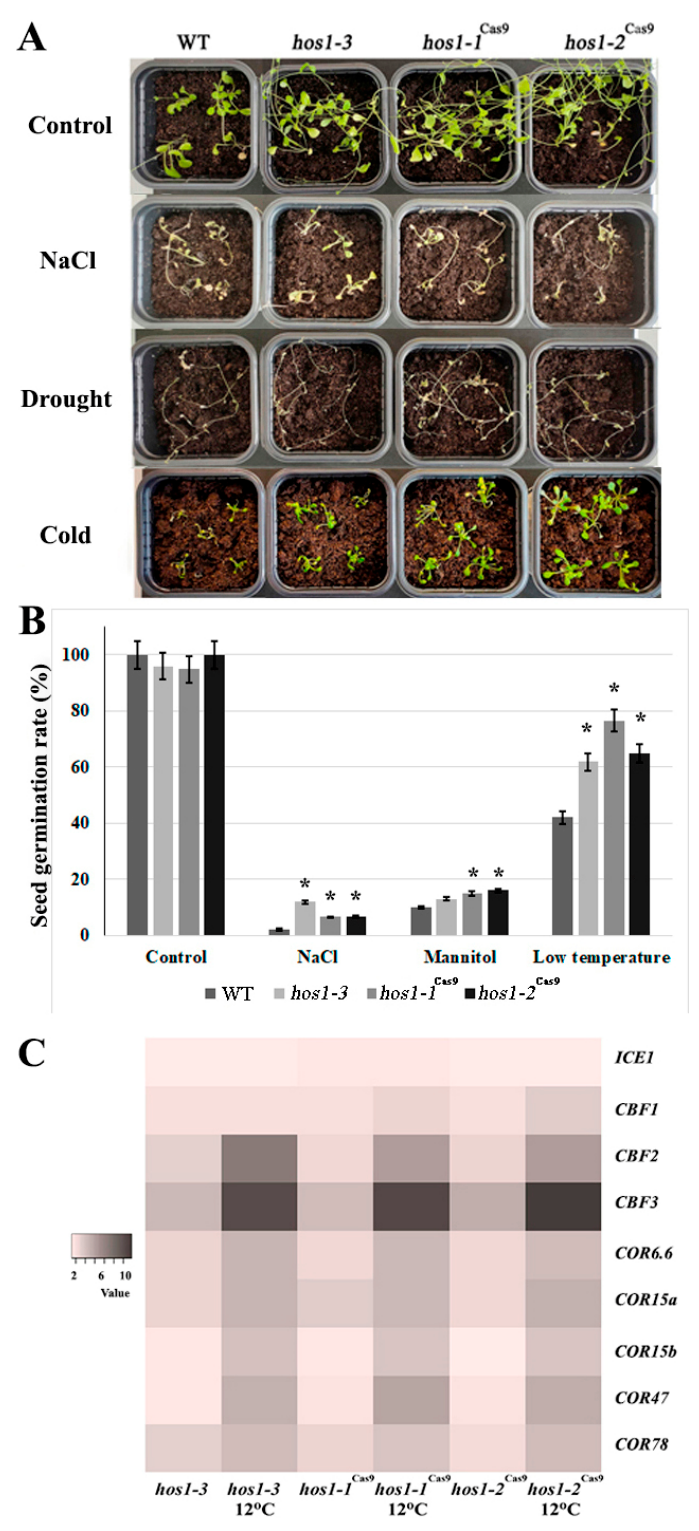
Figure 4. Abiotic stress treatment and expression of CBF regulon genes. ( A ) Phenotypic comparison of the plants under salt, drought and cold stresses. ( B ) Seed germination rates of hos1-3 and hos1 Cas9 plants under abiotic stress treatment. Data are presented as mean ± standard error. Asterisks (*) indicate statistically significant differences of means ( P < 0.05), Student’s t-test. ( C ) A heatmap of the expression fold changes of ICE1 , CBF and COR genes in Arabidopsis hos1 mutants, under normal growth conditions and under cold stress treatment, relative to their expression levels in WT